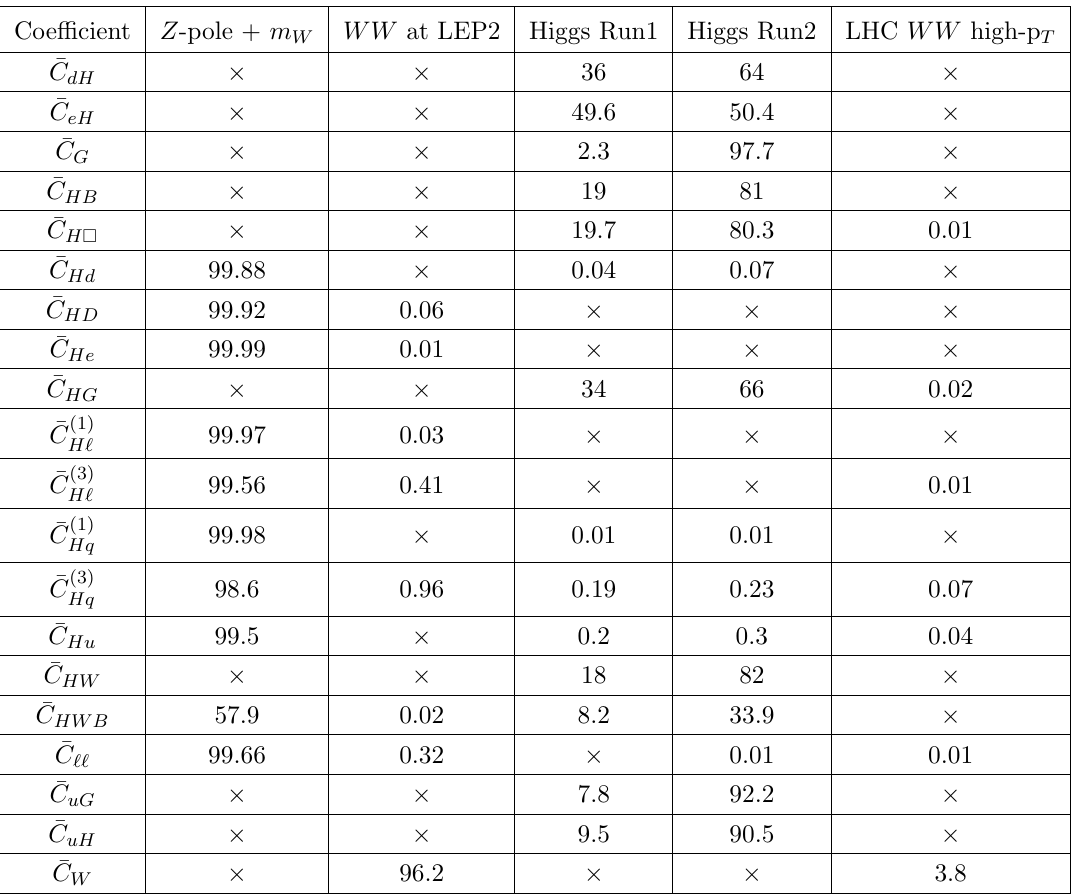
Table 5. Impact of di(cid:11)erent sets of measurements on the (cid:12)t to individual Wilson coe(cid:14)cients in the Warsaw basis as measured by the Fisher information contained in a given dataset for each coe(cid:14)cient. A cross indicates no (current)